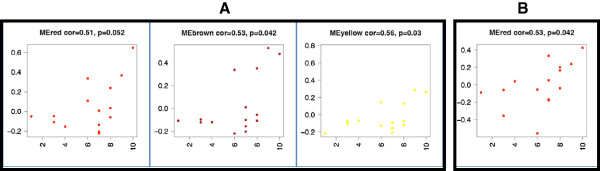
Correlations between module eigengenes and GDS across all HIV + cases. (A) In the frontal cortex, the Brown and Yellow modules have significant positive correlation with GDS, whereas the Red modules shows a mentionable trend. (B) In the frontal white matter, the red module has a significant positive correlation with GDS.